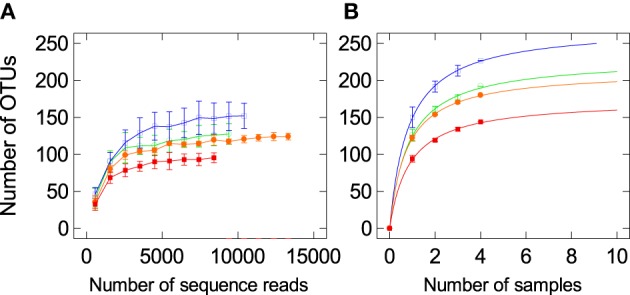
Rarefaction analysis, calculated at 97% dissimilarity, for the assessment of operational taxonomic unit (OTU) coverage within the16S rRNA gene-based cecal bacterial communities in the RES and SUS quail fed the control (RC, blue open square; SC, green open square) or cholesterol (RE, orange closed square; SE, red closed square) diets. (A) The number of OTUs as a function of the number of sequence reads. (B) The number of OTUs as a function of the number of individual quail sampled.